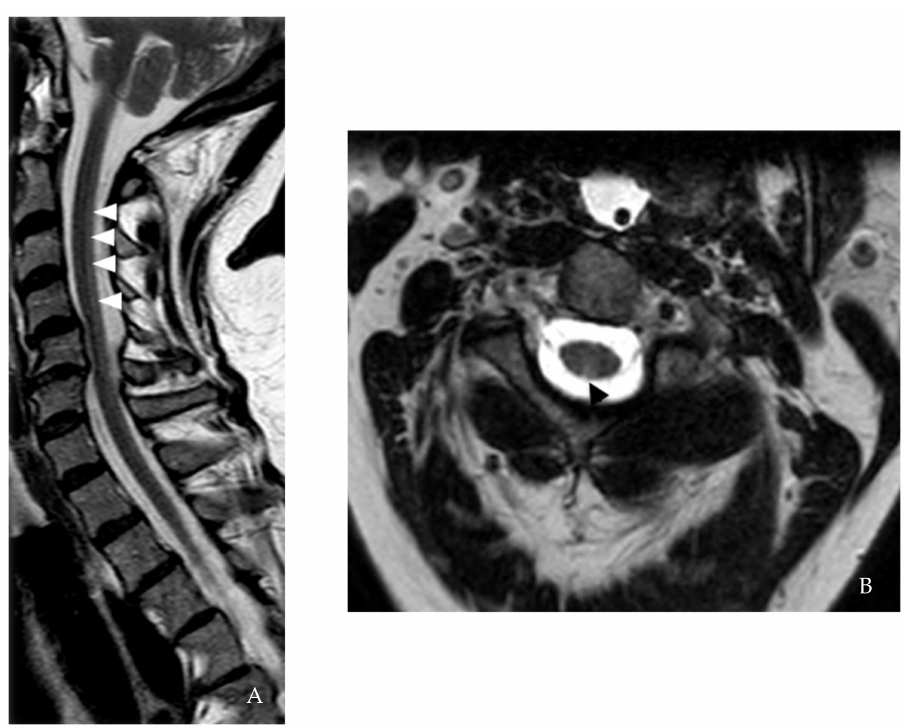
Figure 1. Case I. ( A ) Saggital STIR cervical spine MRI shows selective T2-hyperintensity of the dorsal column bilaterally from C2-5 (white arrows). ( B ) Axial T2 confirmed the presence of the lesion at the same level (black